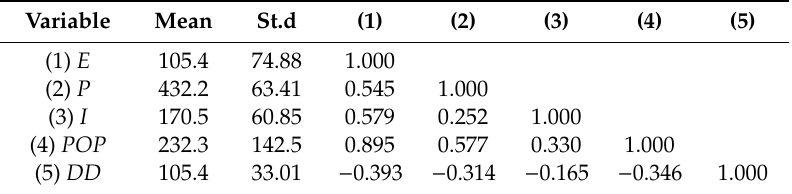
Table 1. Statistical description and correlation